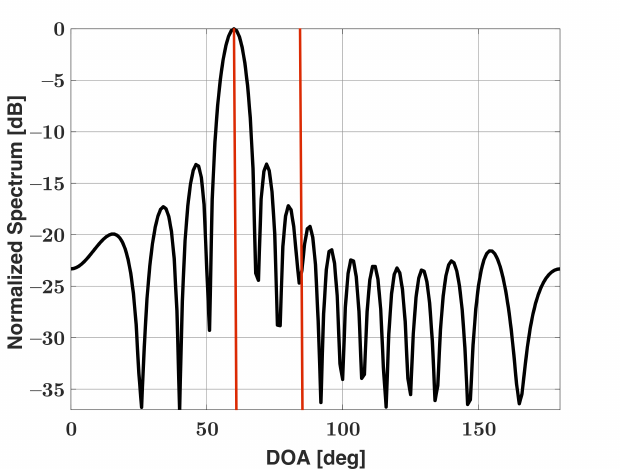
Figure 1. Bartlett spectra for a uniform linear array of 15 elements in the presence of two signals incident at 60 ◦ (25 dB SNR) and 85 ◦ (0 dB